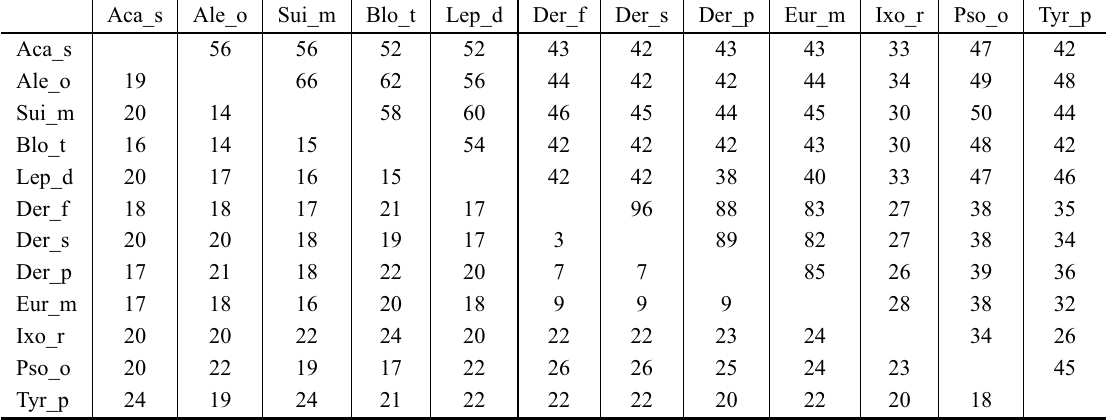
Analyses of similarity between the allergen Der f 2 and its homologous protein fractions from some other species of allergenic mites and ticks by VCETOR NTI 9.0 software.